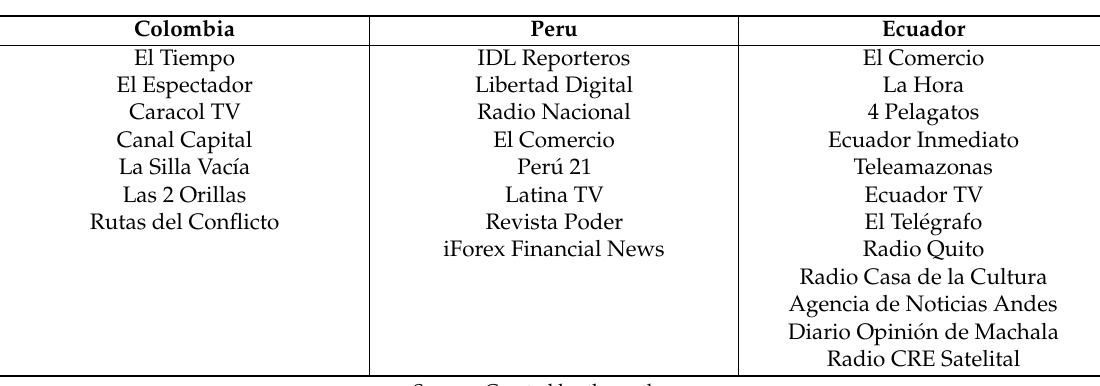
Table 2. Media organizations where the consulted journalists